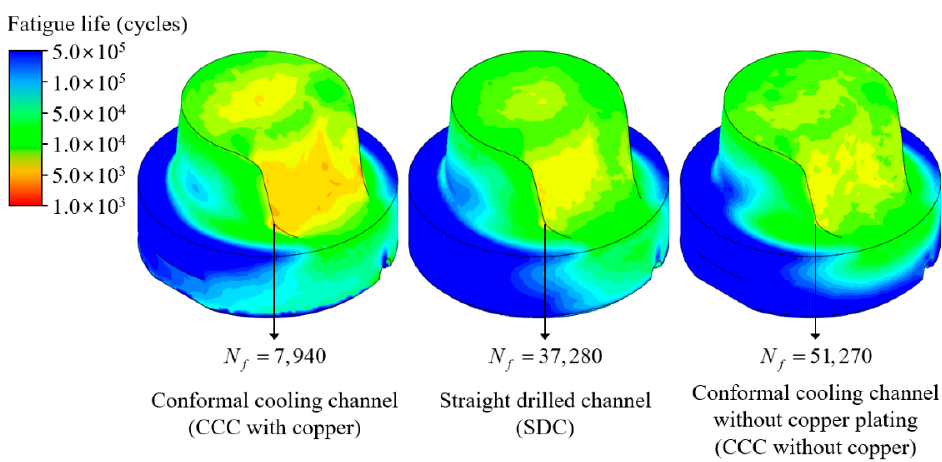
Figure 17. Fatigue life prediction results from three types of cooling channel.